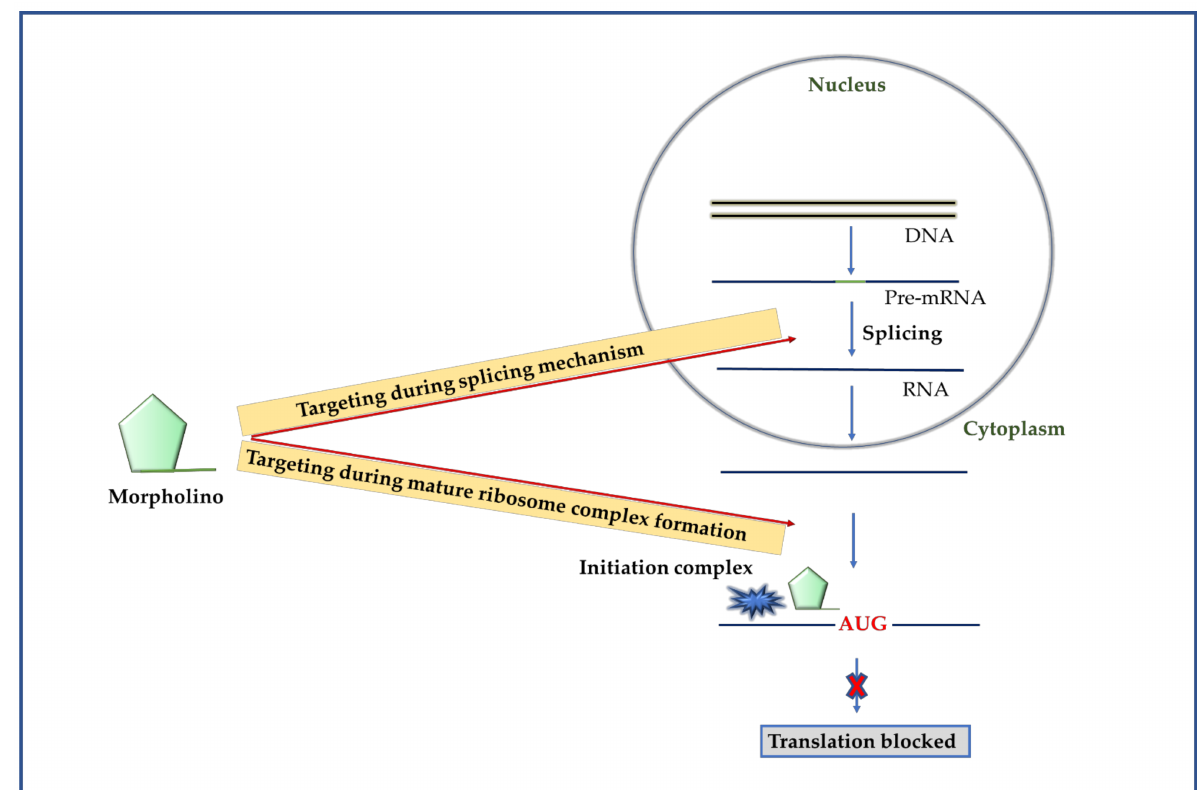
Figure 6. Morpholino as an antiviral. ( left ). The general structure of a morpholino phosphoroamidate. ( right ). Pathway of gene silencing by morpholino. Morpholino can block the mRNA maturation during splicing mechanism within the nucleus. It can also block the translation initiation complex binding site on mRNA and prevent the translation